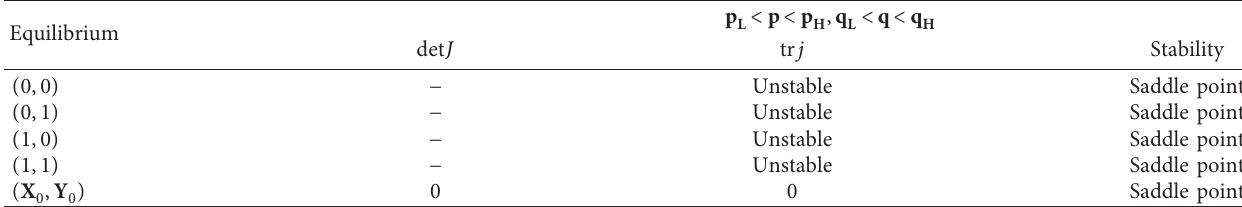
Table 6: Equilibrium point local